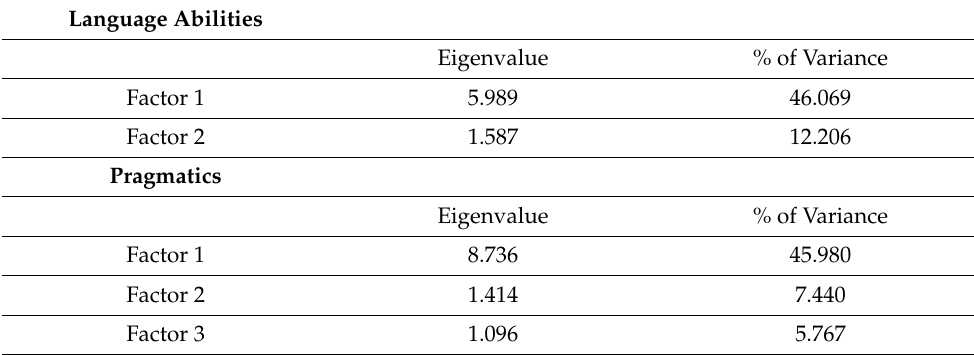
Table 5. Results of factor analyses.